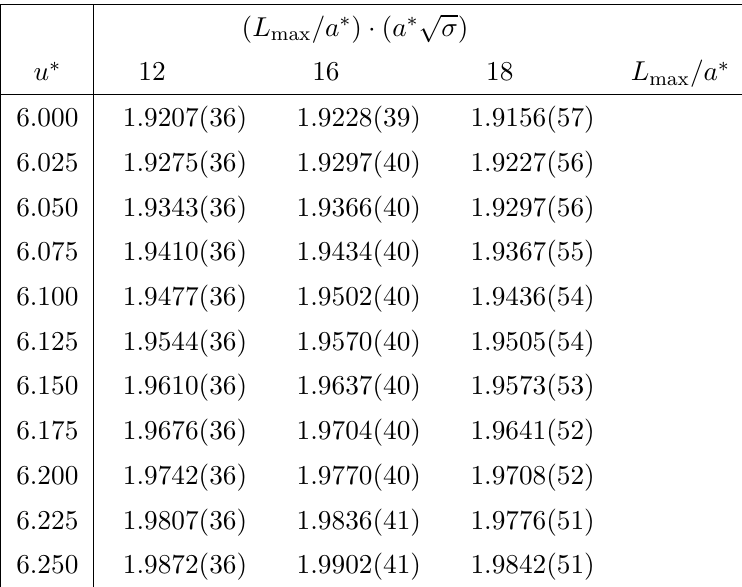
p (cid:27) at each u (cid:3)